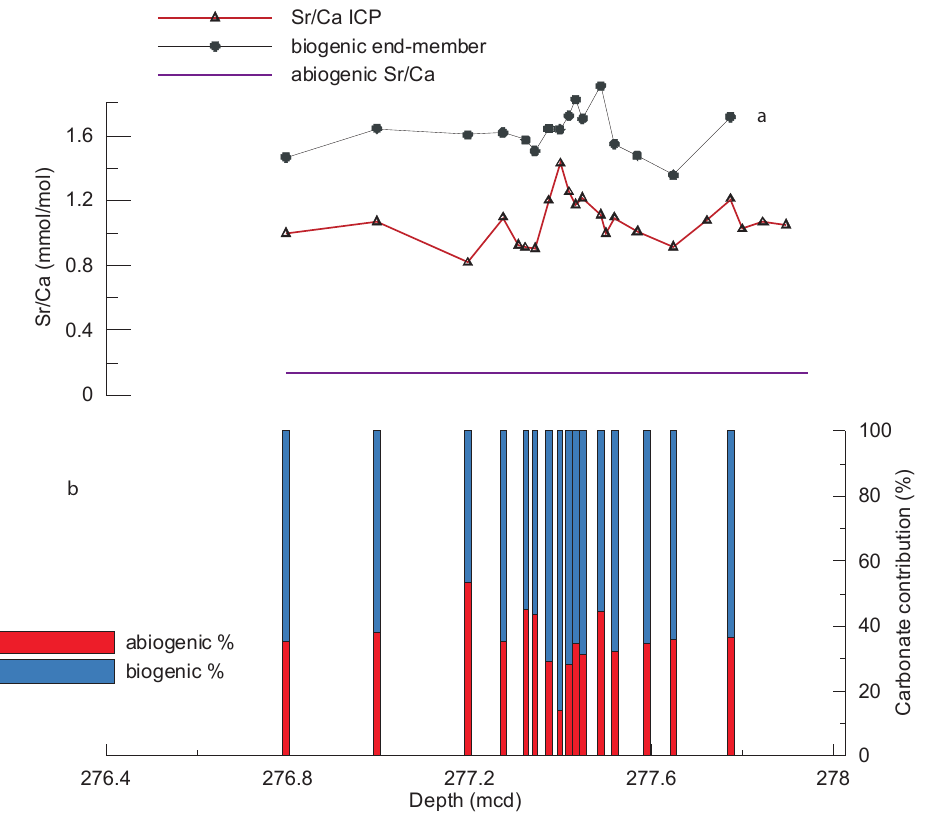
Fig. 8. (a) Plot showing the biogenic end-member calculated from ion probe values and the size fraction Sr/Ca measured by ICP, which together with the abiogenic value of 0.13 were used to calculate the abiogenic calcite contribution. (b) The abiogenic versus the biogenic calcite contribution to the carbonate that makes up the 5–8µm size fraction, ETM2 Site